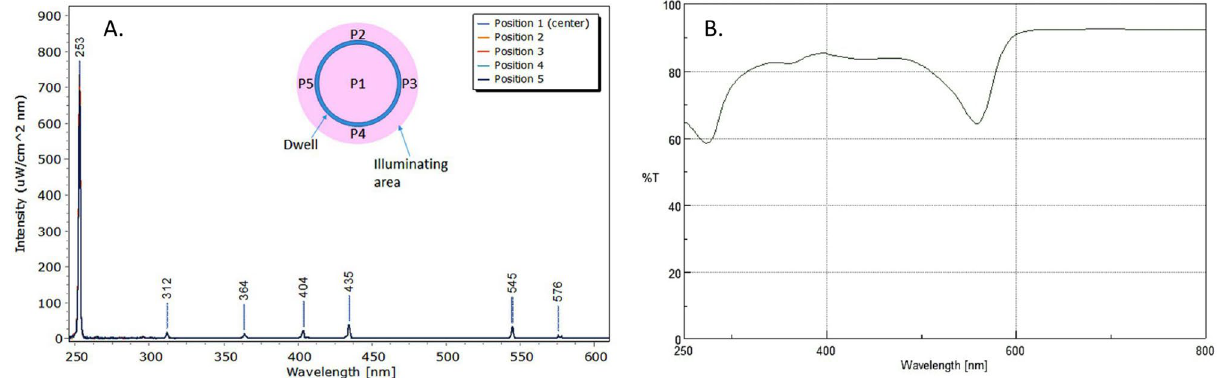
Figure 5. Mercury lamp spectrum measured in the five positions ( A ). Inset: scheme of the illuminated dwell and the measuring position. UV–vis transmission spectrum of the Dulbecco’s Modified Eagle’s Medium (DMEM) in a 1 mm quartz cuvette ( B